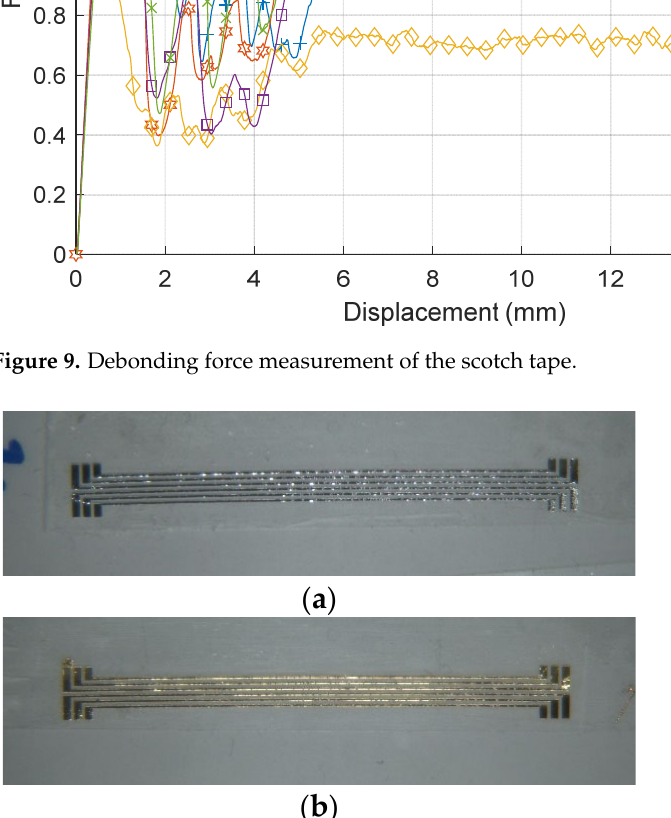
Figure 9. Debonding force measurement of the scotch tape